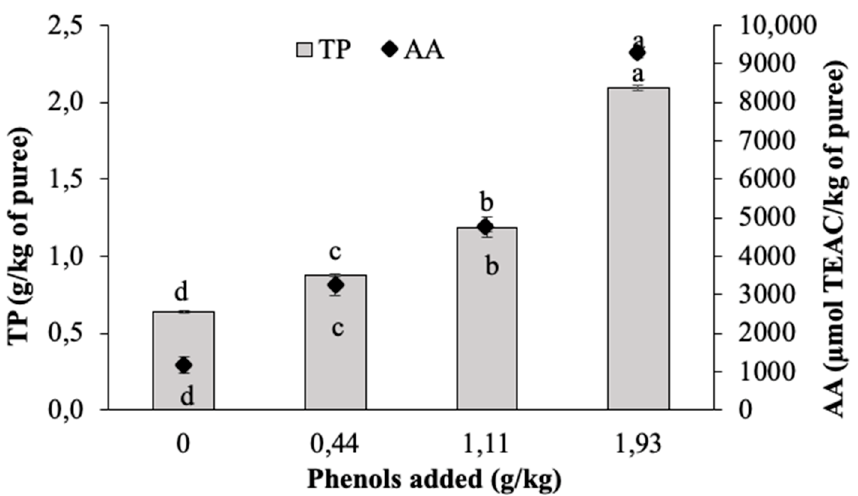
Figure 2. Antioxidant activity and total phenol content of BP enriched with increasing concentrations of UG phenols. The data are the mean of three replicates. The bars represent standard deviation. Different superscript letters represent significant differences ( p ≤ 0.05).